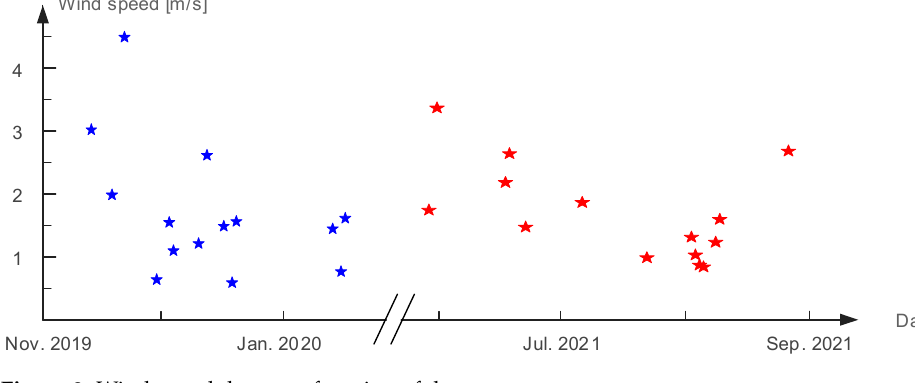
Figure 3. Wind speed data as a function of date.